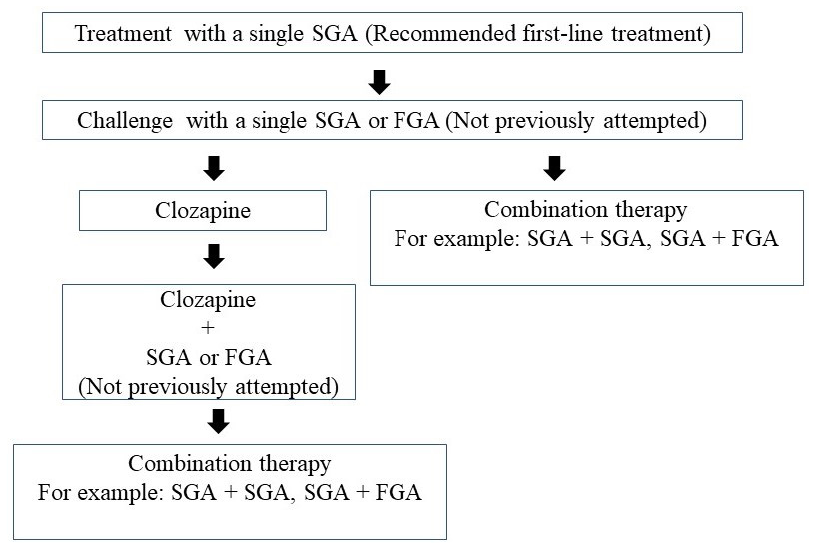
Figure 1. Clinical steps in antipsychotic polypharmacy (APP). FGA: first-generation antipsychotic, SGA: second-generation antipsychotic.